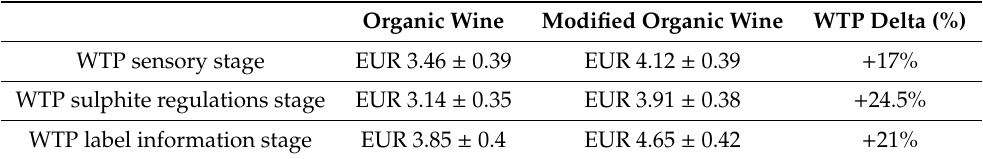
Table 5. Average willingness to pay (WTP) ( ± standard error) for the two wines featuring the organic certification label for each stage in the procedure (WTP shown in euros). Delta = the di ff erence in average prices between the modified organic wine and the organic wine.